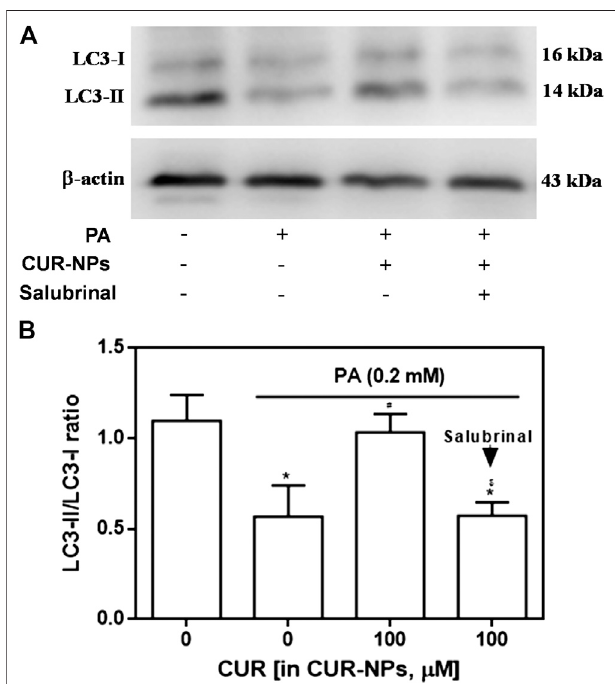
FIGURE 6 | Effects of CUR-NPs on the expression of autophagy pathway-related proteins in cardiomyocytes exposed to PA (A) Representative images of LC3-I and LC3-II expression by western blot (B) Quantitative analysis of the LC3-II/LC3-I ratio. Salubrinal: 30 μ M * p <